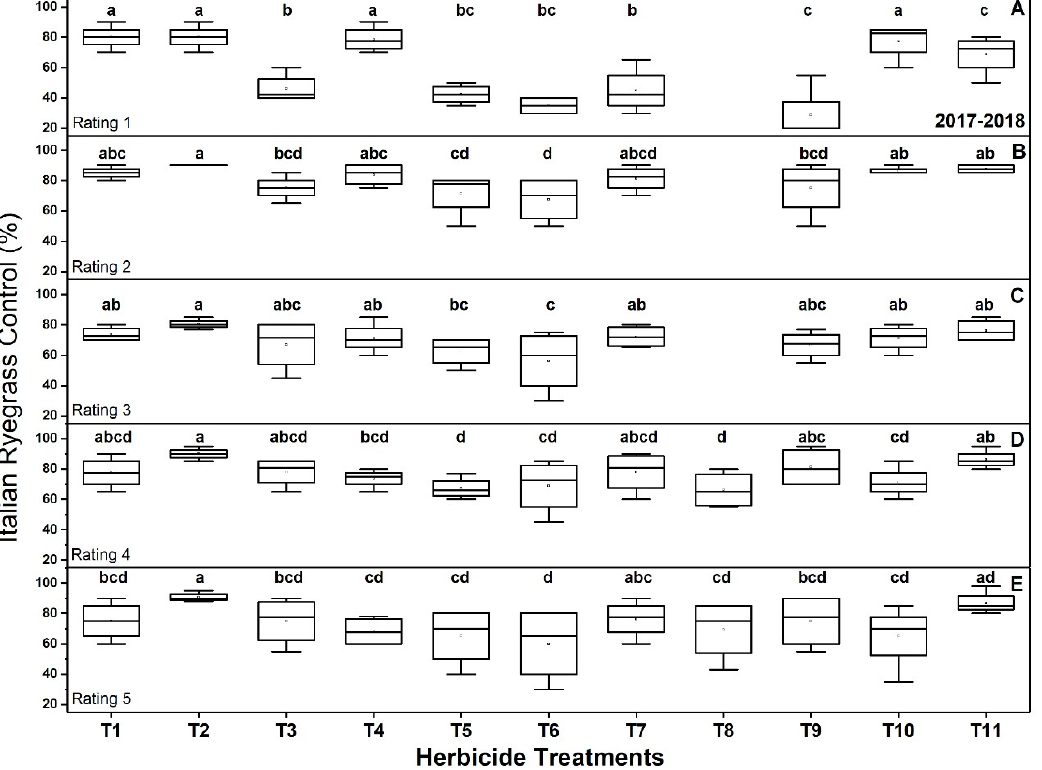
Figure 2. Glyphosate-resistant Italian ryegrass Control Study in 2018 showing percent weed control.